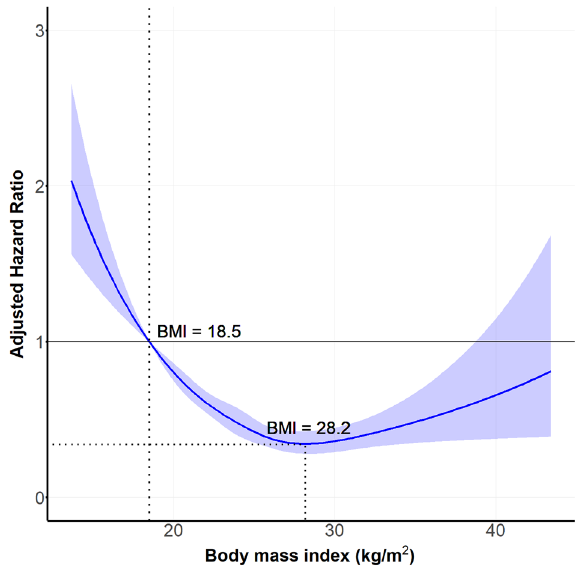
Figure 3. Continuous association between BMI and all-cause mortality in acute severe HTN patients. Restricted cubic splines showing a continuous adjusted association between BMI and risk of all-cause mortality in patients with HTN crisis. The shaded area shows the 95% confidence interval for the estimated hazard ratio point associated with different BMI levels after adjusting for age, sex, hypertension, diabetes mellitus, dyslipidemia, ischemic stroke, hemorrhagic stroke, chronic kidney disease, end-stage renal disease, smoking, and alcohol consumption. (Reference BMI :18.5 kg/m 2 ). BMI, body mass index; CI, confidence interval; HTN, hypertension.